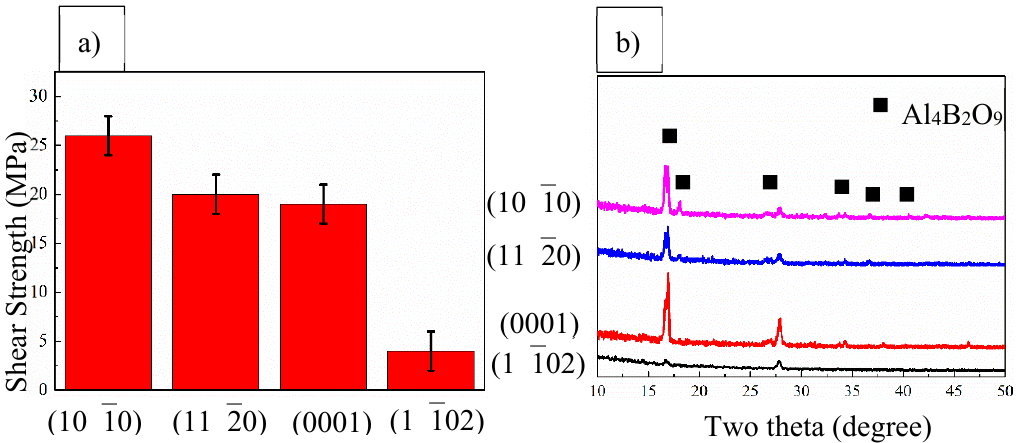
Figure 3. ( a ) The shear strength of the joint between polycrsystal alumina and sapphire with different orientations, ( b ) The XRD (X-ray diffraction) pattern of the fracture surface on the sapphire side, where Al 4 B 2 O 9 whiskers can be indexed and the intensity of the peaks differs from each other.